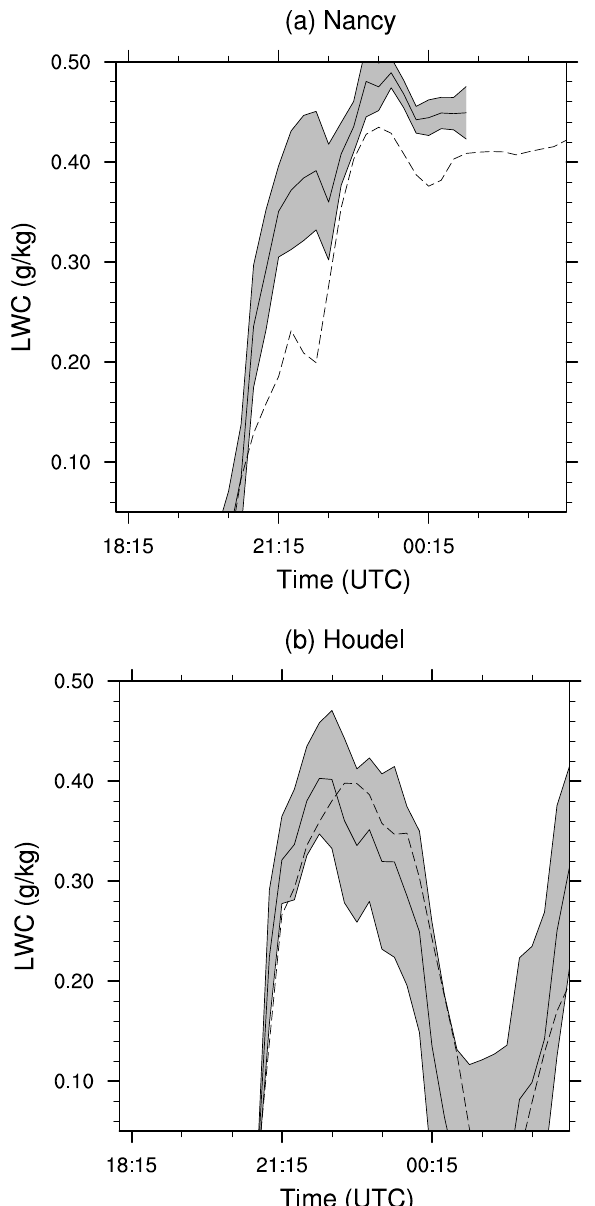
Figure 6. Time series of liquid water content (LWC) at 2 m for Nancy ( a ) and Houdel ( b ). M500m is represented by a dashed line and M50m by a solid line. The standard deviations of M50m at 500 m horizontal scale are indicated by the grey